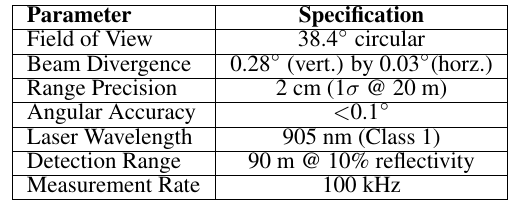
Table 1. Manufacturer Instrument Specifications for Livox Mid-40 (Source: www.livoxtech.com)